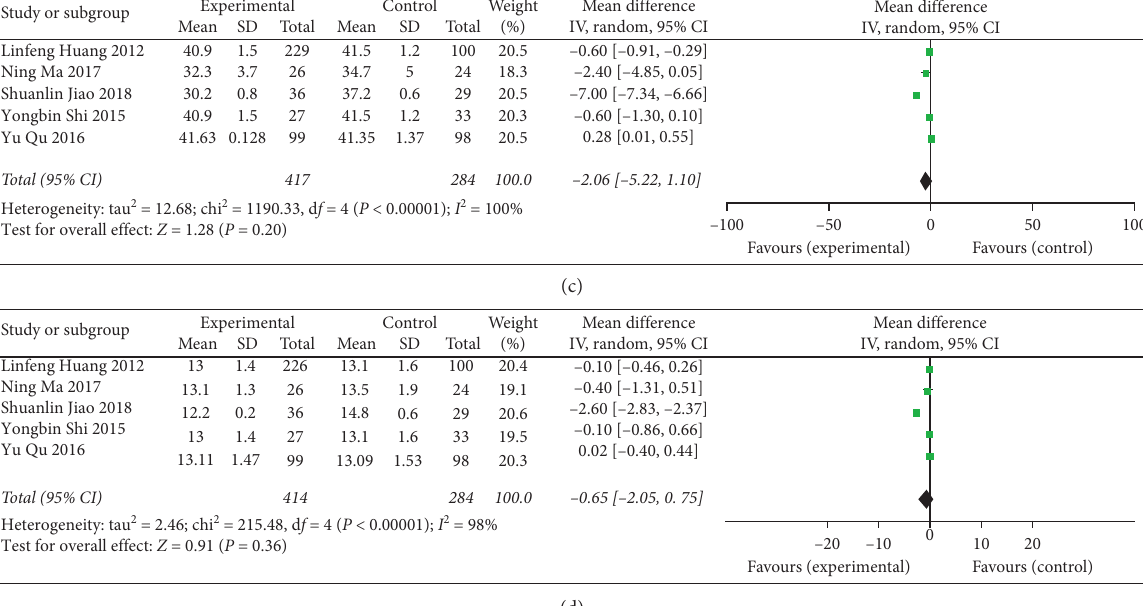
Figure 8: Effect and safety of anticoagulant combined with traditional Chinese medicine: (a) appearance of thrombosis and preventive effect of anticoagulant on PVT; (b) analysis of PLT; (c) analysis of APTT; (d) analysis of